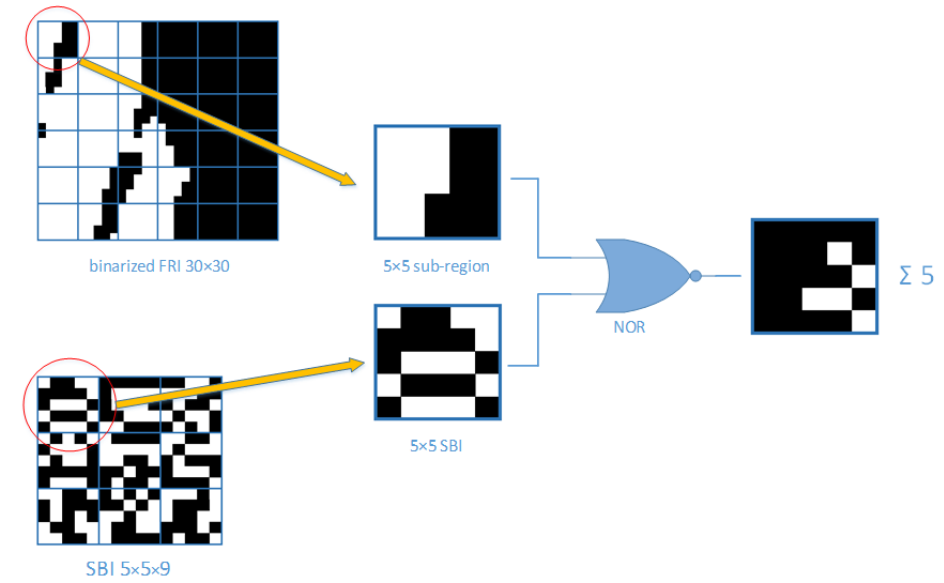
Figure 1. SYBA descriptor formation.